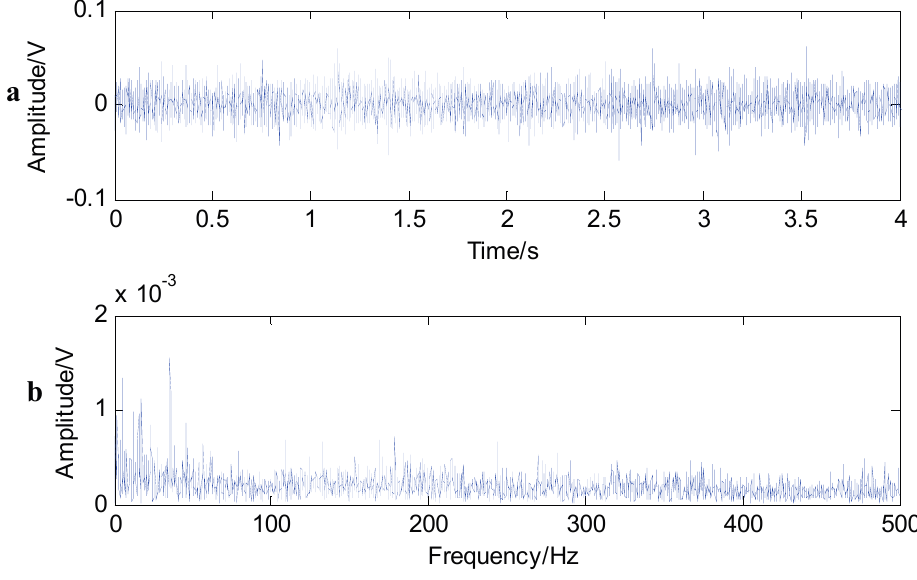
Figure 13. Experimental apparatus. 1, variable speed drive; 2, torque transducer and encoder; 3, parallel shaft gearbox; 4, test point; 5, programmable magnetic brake.